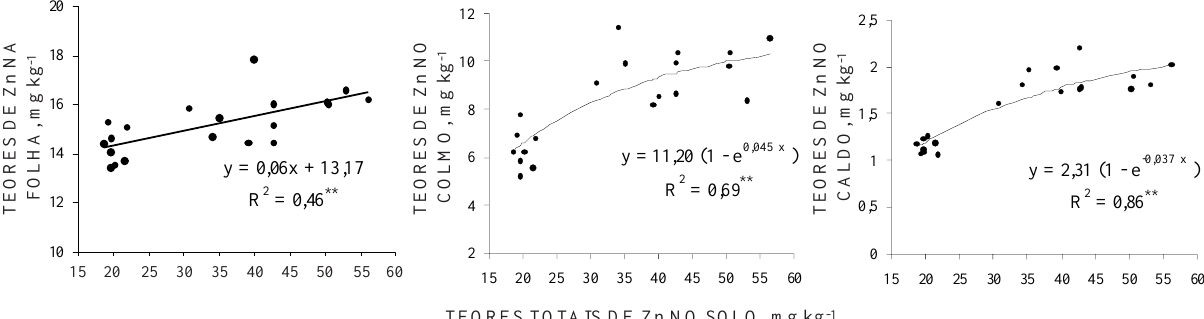
Figura 1. Relações entre teores de zinco na folha, colmo e caldo da cana-de-açúcar e teores totais no solo, considerando a aplicação do composto de lixo no ano agrícola 1997/98. ( ** Modelo ajustado significativo a P ££ ££ £ 0,01 pelo teste